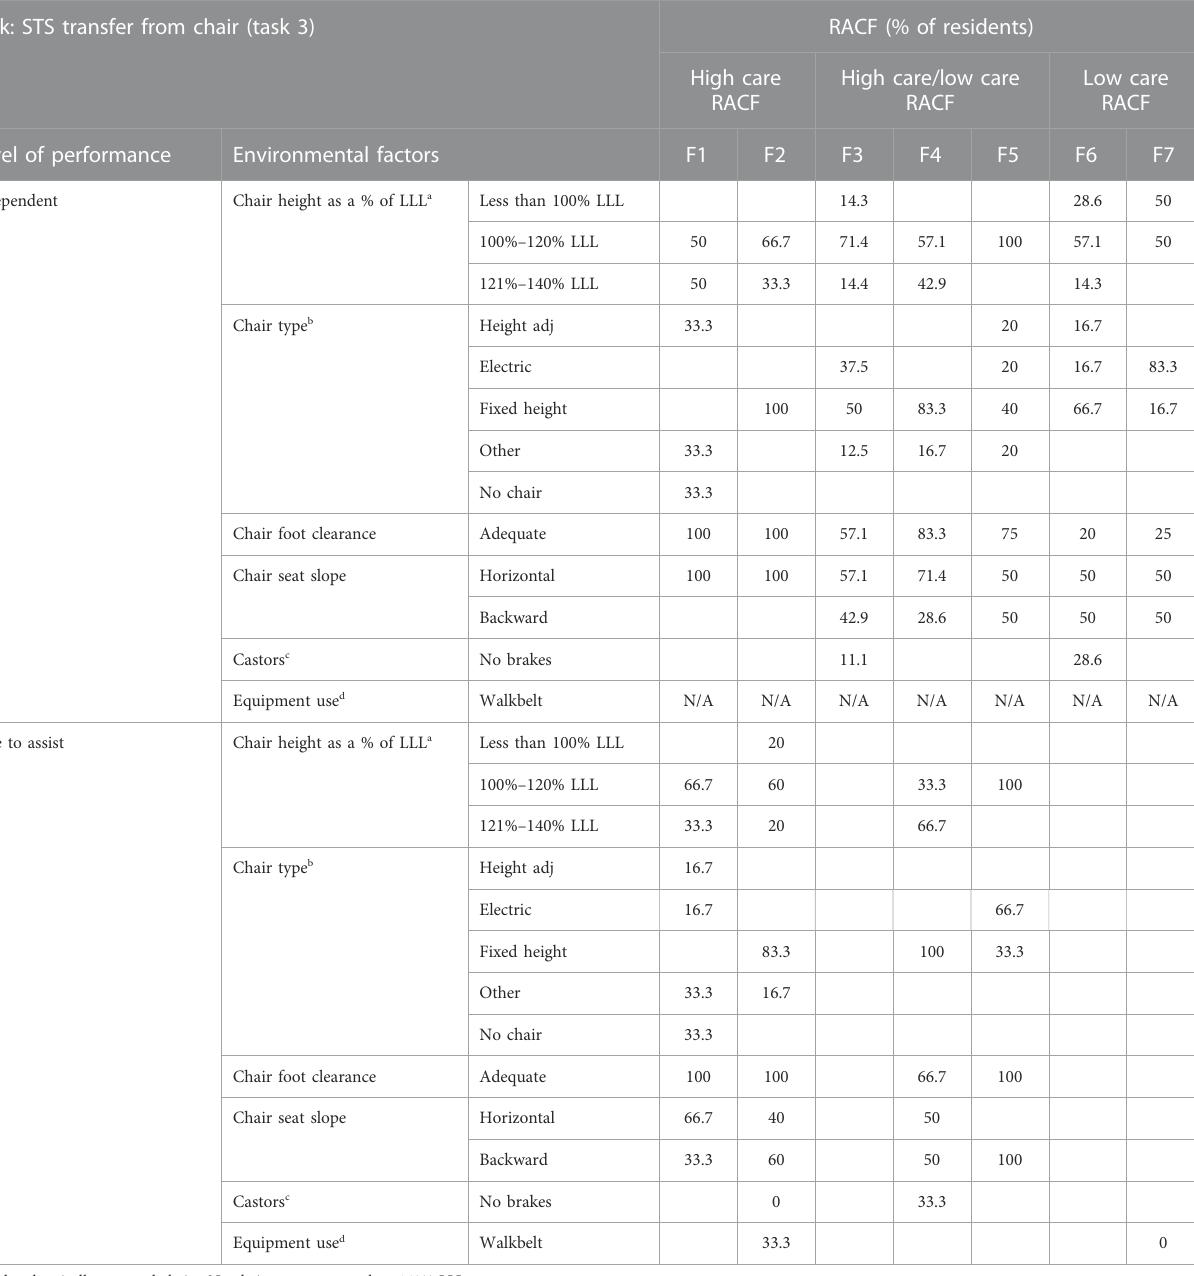
TABLE 4 Summary of the relationship between level of performance with STS transfer from chair (Task 3) and key environmental factors. Task: STS transfer from chair (task